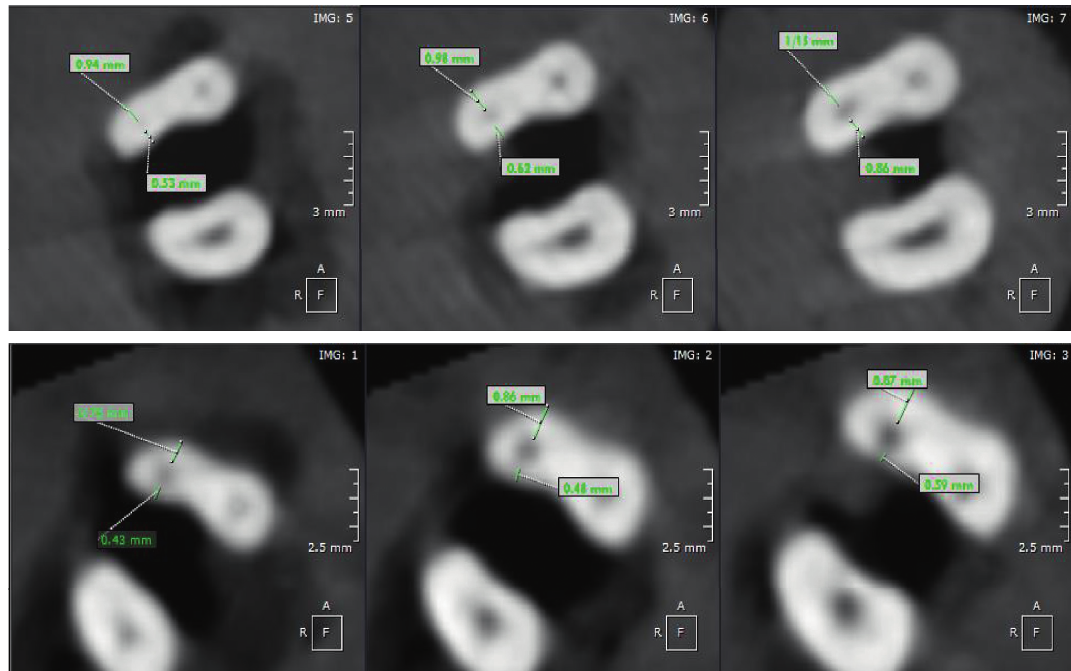
Figure 3: Typical CBCT images of samples. Table 1: Amount of dentin removed from mesial and distal walls of MB canals.